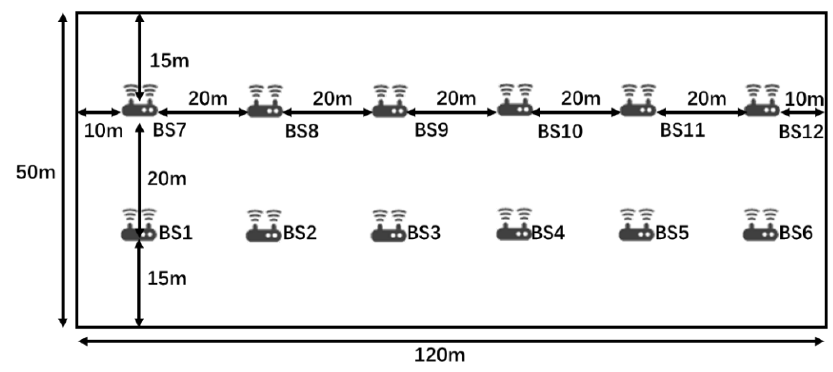
Figure 5. Simulation Scenario with 12 base stations (BSs).